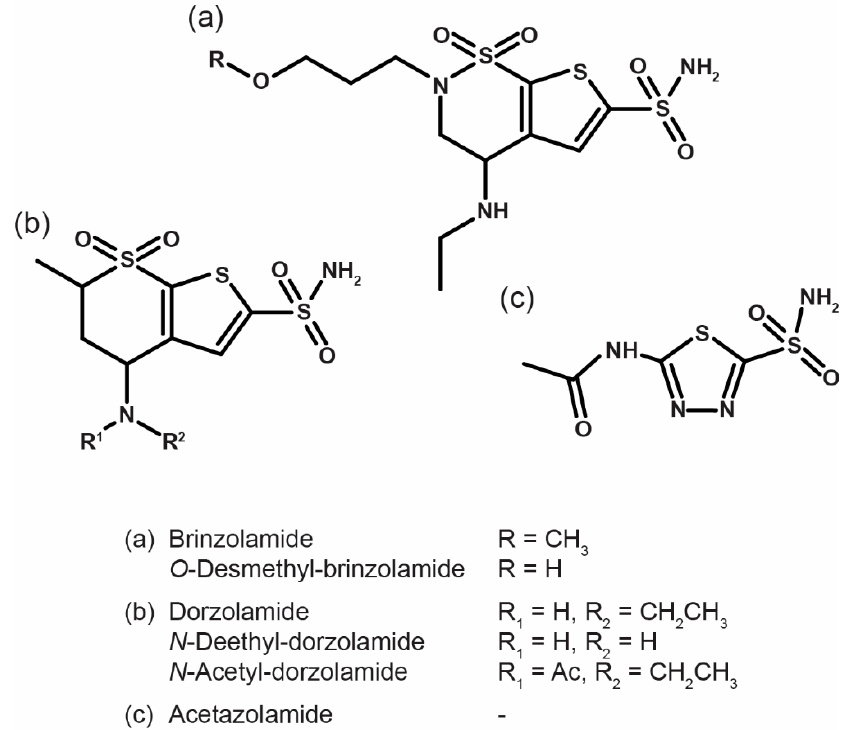
Figure 1. Skeletal formula of the carbonic anhydrase inhibitors and their metabolites included in the analytical method.